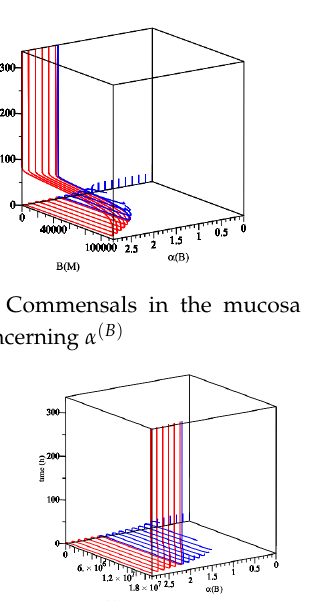
the basic reproduction numbers. This display is plotted by fixing the parameter values from Table 3 in Model (14).